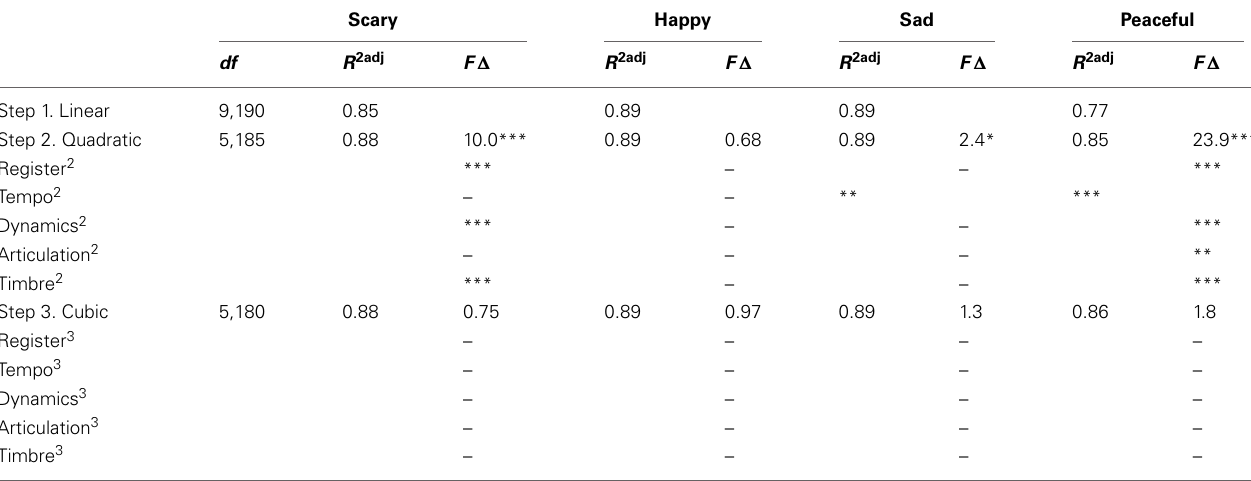
Table 2 | Hierarchical regression comparing linear, quadratic, and cubic